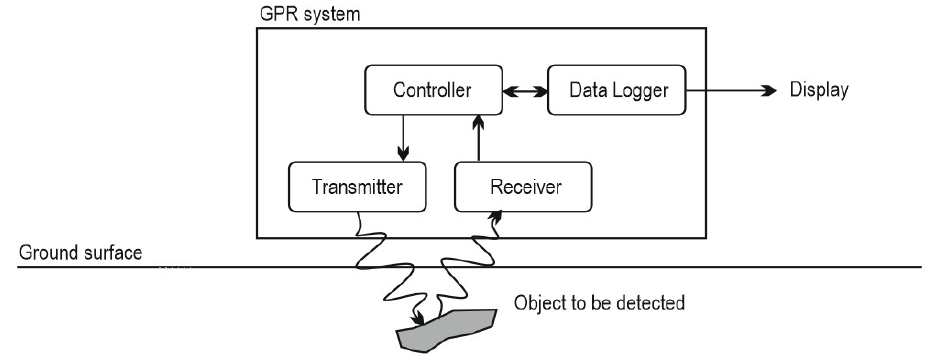
Figure 1. General layout of a GPR system.